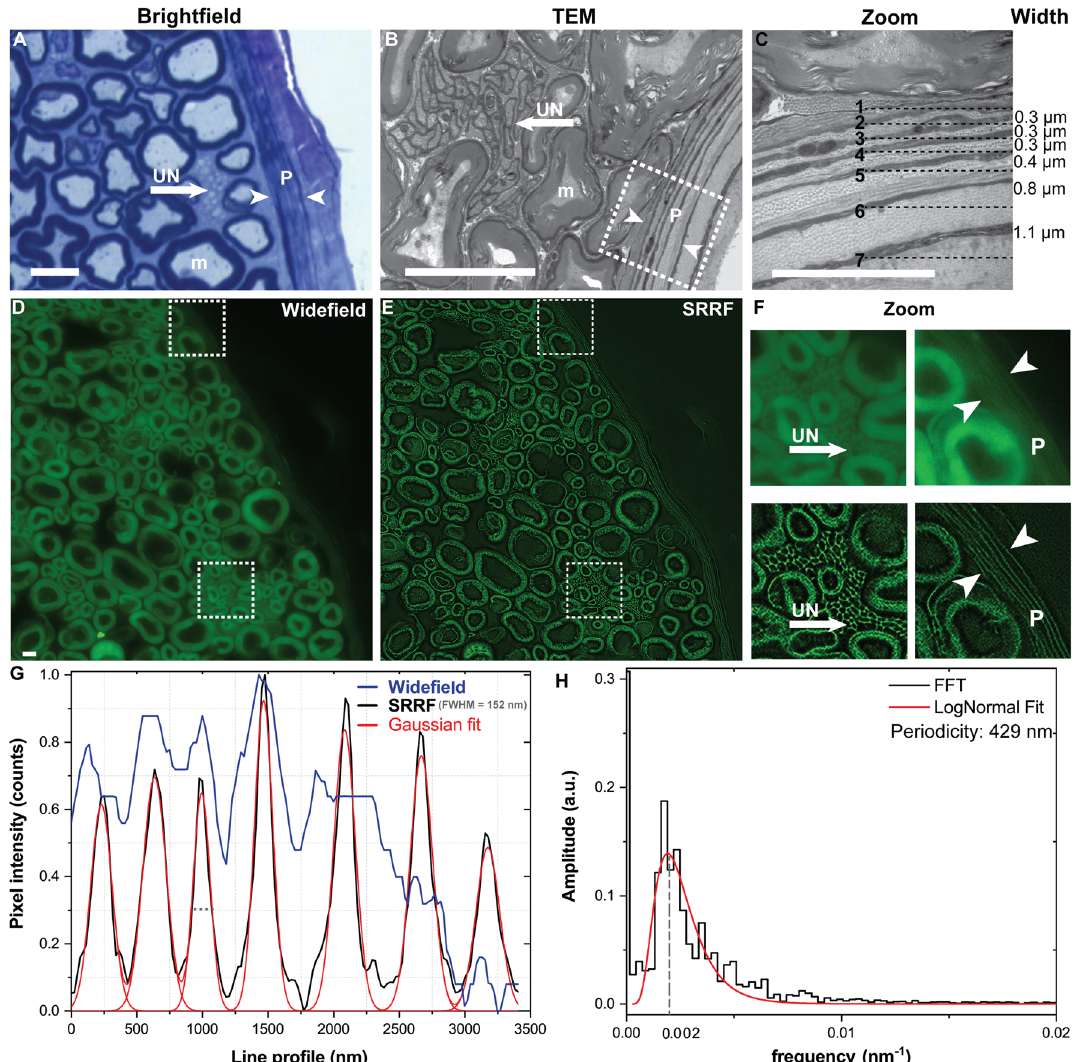
Figure 2. Imaging of murine peripheral nerve using light, electron and super-resolution microscopy. Wildtype murine sciatic nerve post-fixed with osmium tetroxide and counterstained with toluidine blue, and imaged using brightfield ( A ) and transmission electron ( B,C ) microscopy. Marked examples of myelinated fibers (m), unmyelinated fibers (UN, arrow), and perineurium (P, arrow heads) in the images. ( D–F ) Sox10-Venus sciatic nerve (expressing a GFP variant within Schwann cells) cross-section stained with FluoroMyelin Green and imaged using widefield fluorescence microscopy with resolution enhancement via post hoc SRRF processing. ( G ) Line profile along the direction of two arrowheads in ( F ) demonstrating resolution of seven individual layers of the perineurium using SRRF imaging, similar to that seen with EM in ( C ); layers cannot be